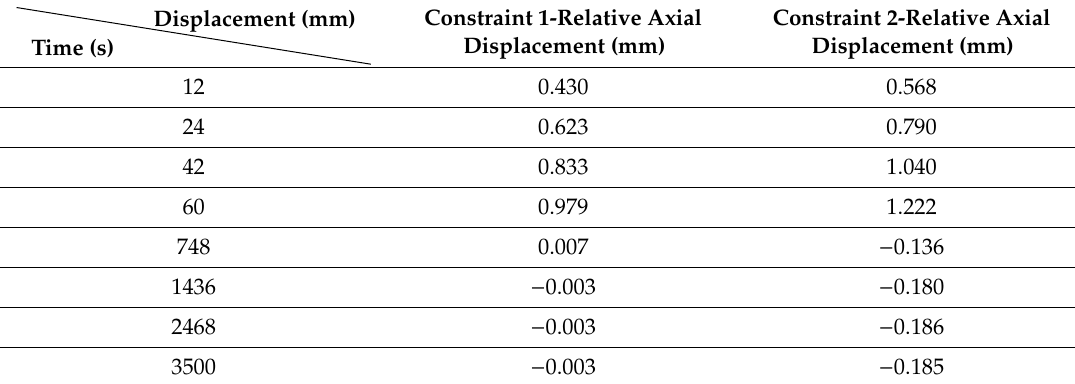
Figure 8. Relative displacement curve of axial deformation at the bottom of pressure plate. Table 1. Comparison of relative axial displacements under different constraints.